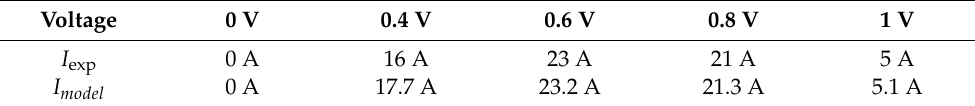
Table 4. Experimental voltage and model voltage under different current conditions.